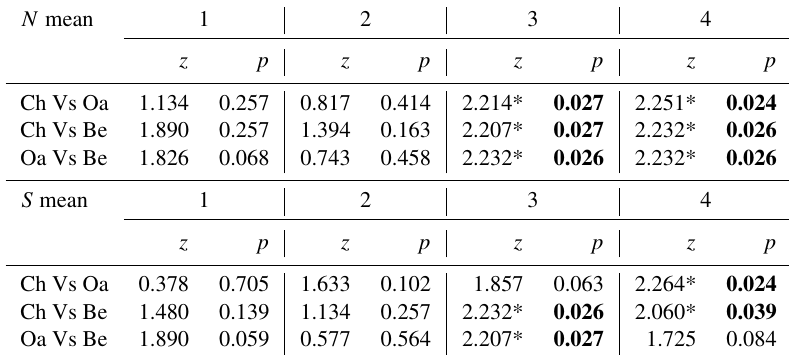
Table 3. Comparison of mean abundance and mean richness between paired forest habitats (Ch is chestnut; Oa is Turkey oak; Be is beech woods) for each age class (from 1 to 4). Z and p values (Wilcoxon test) are reported. Significant values are in